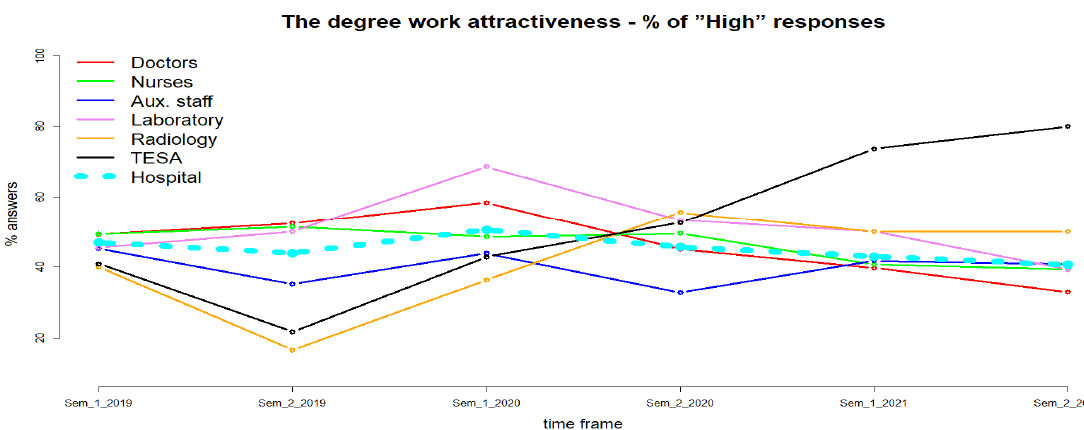
Figure 3. Work interestedness.